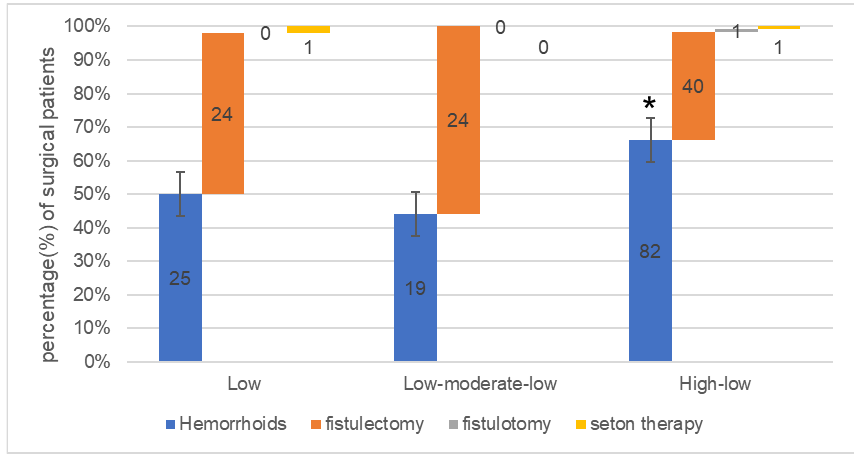
Figure 4. Percentage-stacked histogram of surgical and pain trajectories. The number in each column indicates the number of patients in that group. * indicates p <